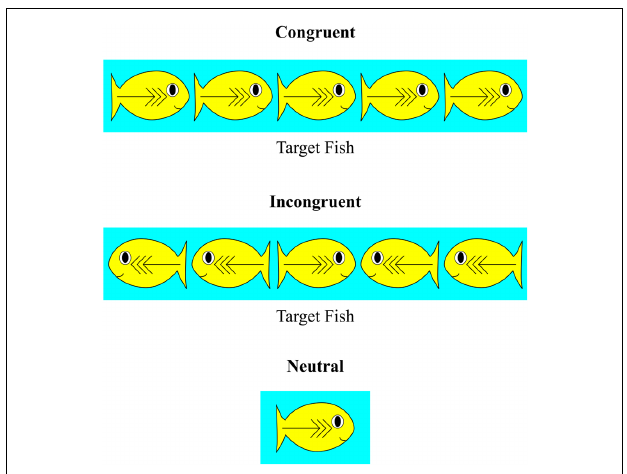
FIGURE 1 |A set of stimuli used in theAttention NetworkTest for three types of trials.